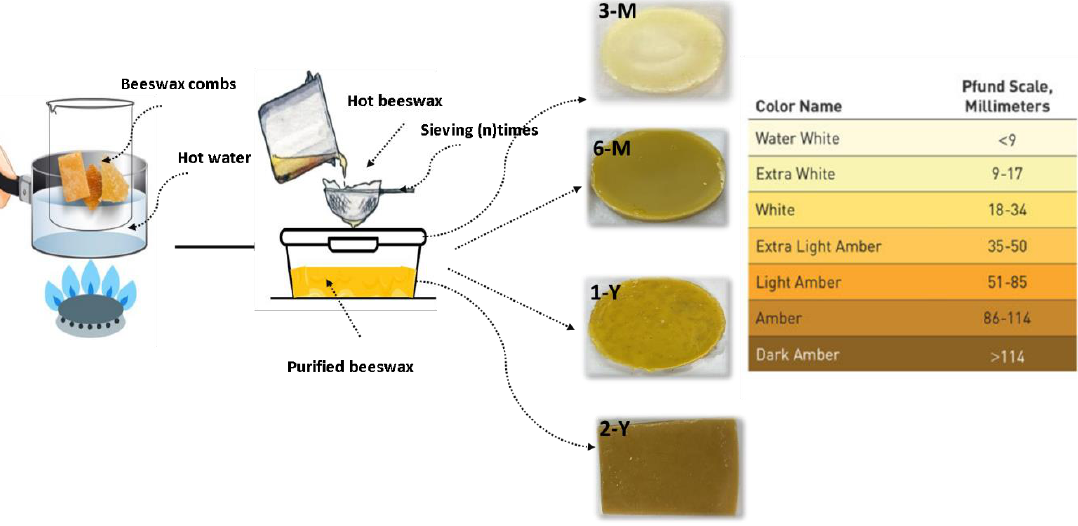
Figure 1. The melting extraction method of four BW samples with different storage times [17,18]